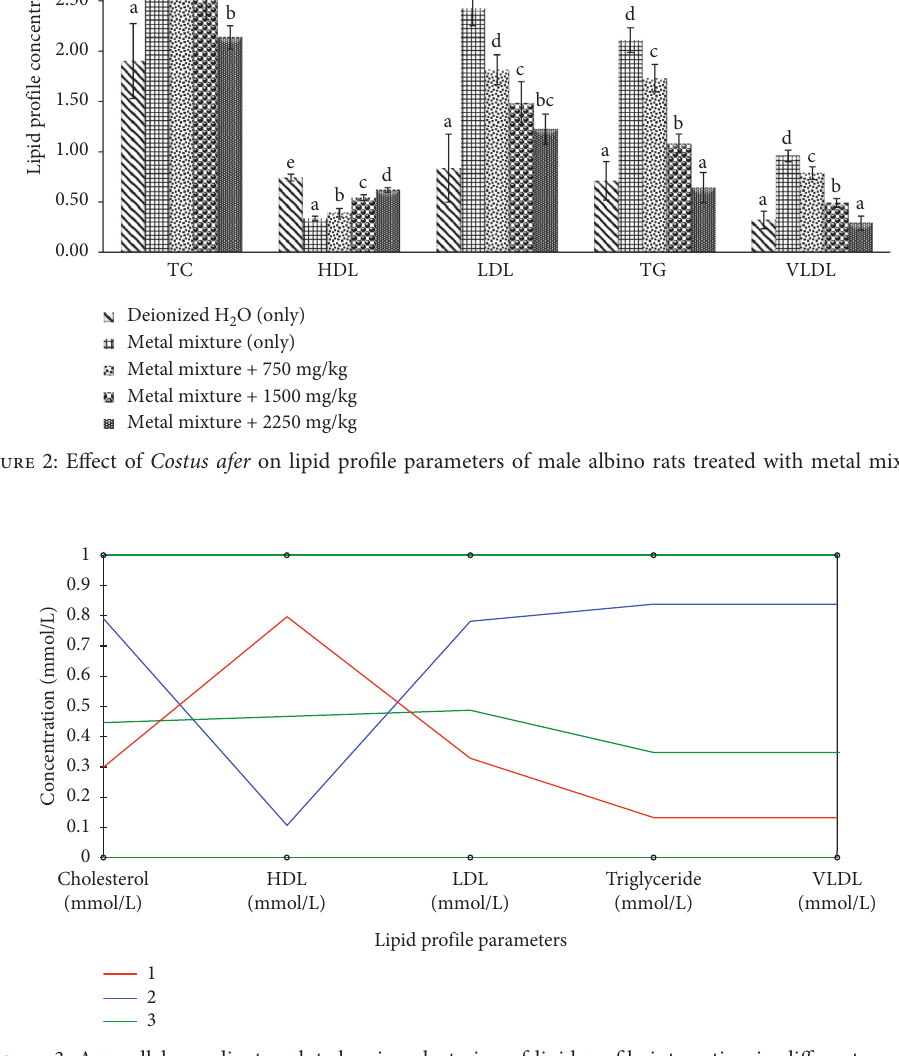
Figure 3: A parallel coordinates plot showing clustering of lipid profile interaction in different groups.